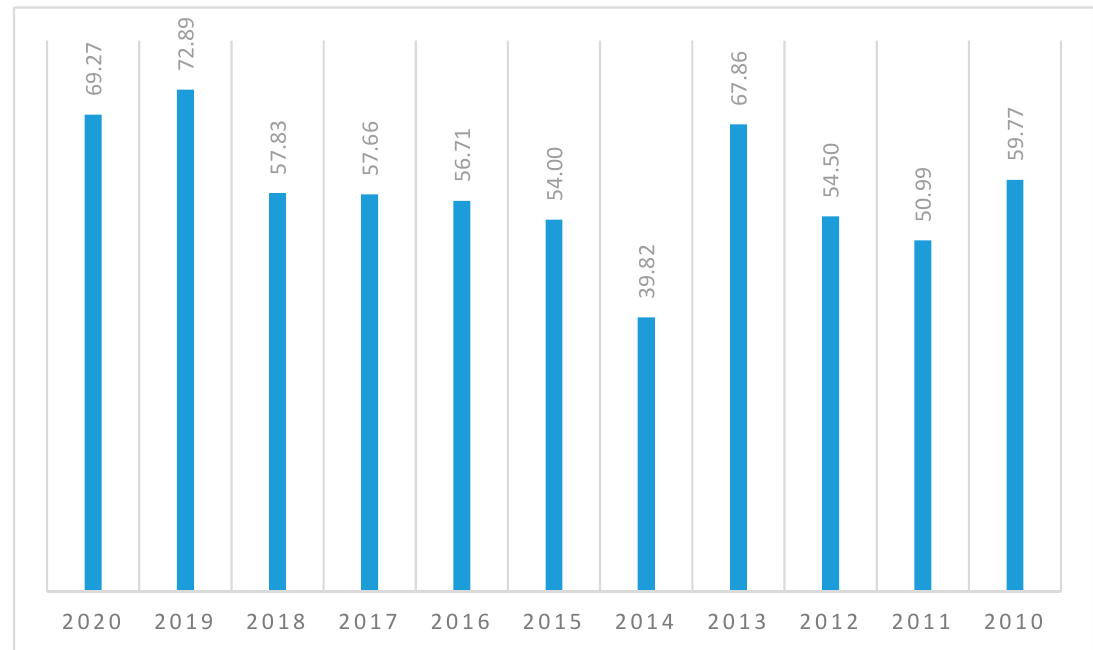
Figure 1. Revenues of Miejska Energetyka Cieplna (MEC) Sp. z o.o. in the years 2010–2020.